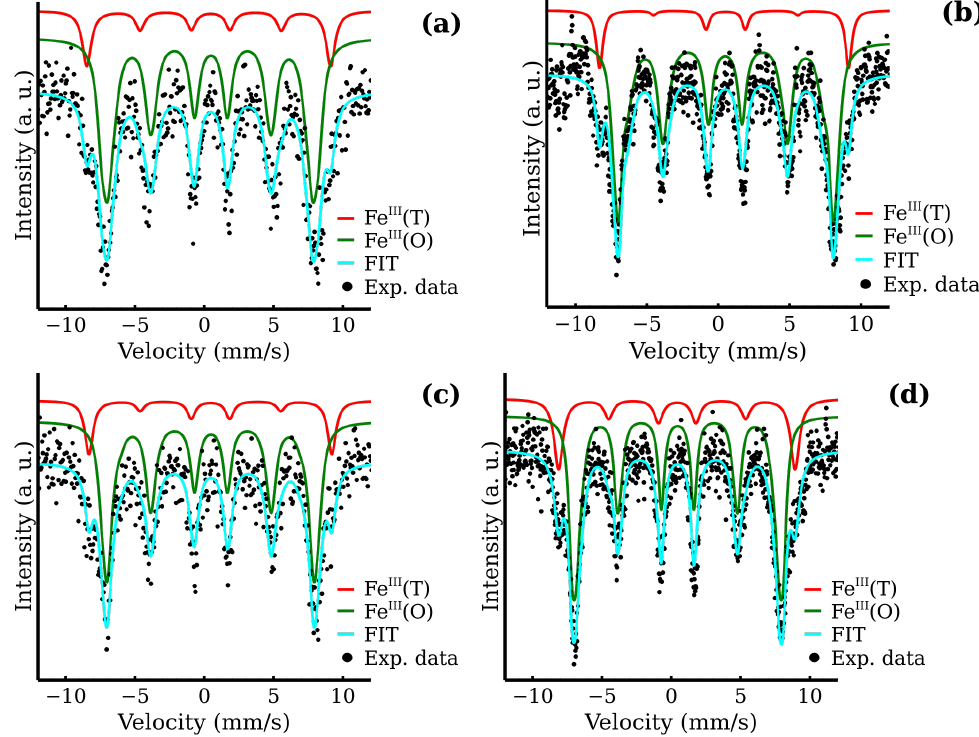
Figure 9. Low temperature Mössbauer spectra in the external magnetic field of MW samples: ( a ) MW- 5, ( b ) MW-10, ( c ) MW-20 and ( d )